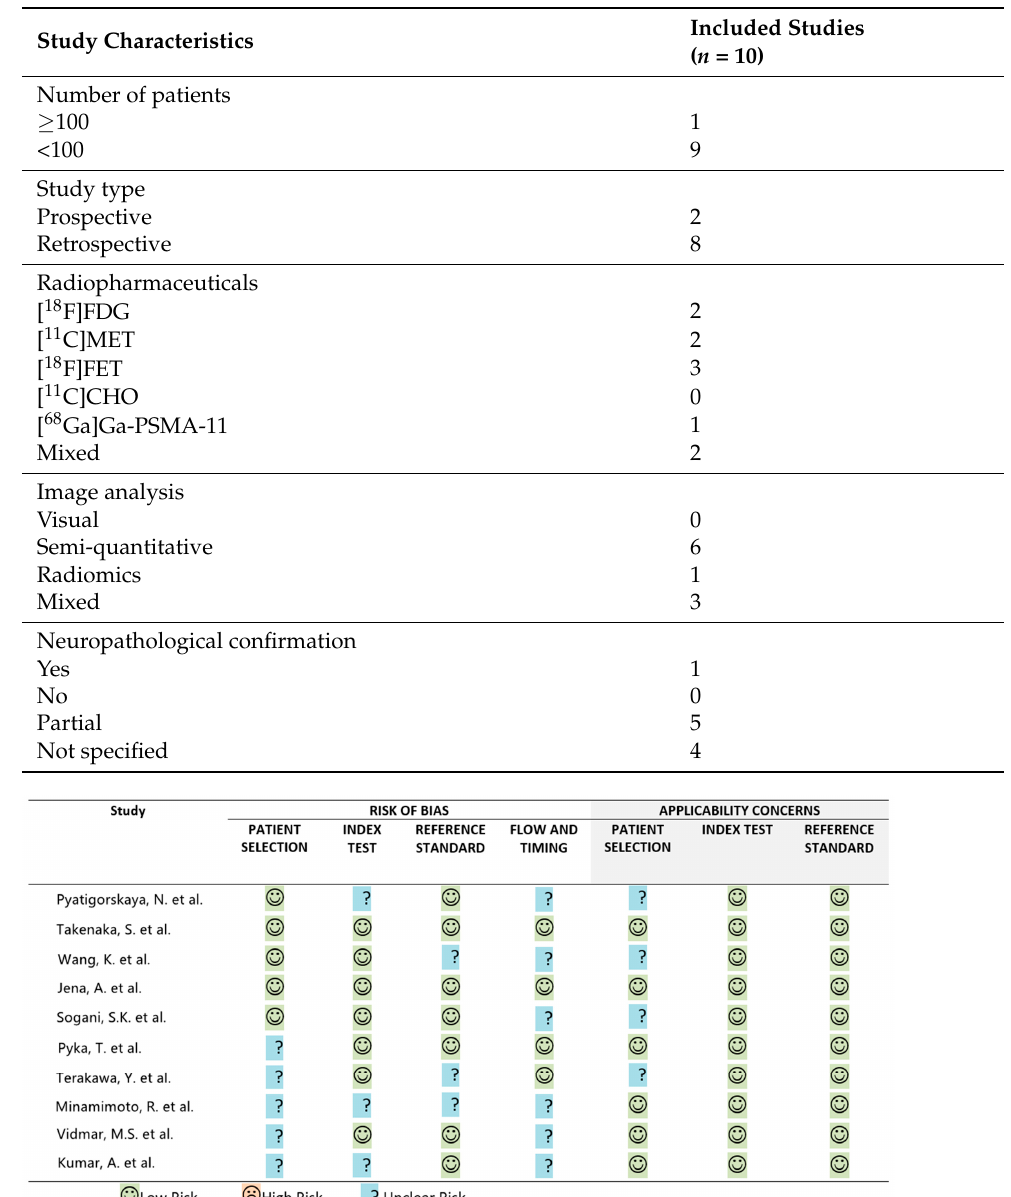
Table 1. Summary of the characteristics of included studies.